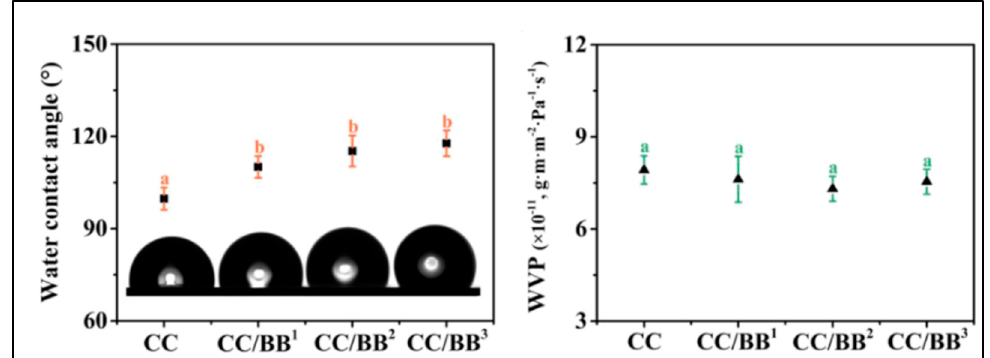
Figure 7. Water contact angle (WCA) values and the water vapour permeability (WVP) of sodium carboxymethylcellulose-carrageenan (CC) films alone and with self-assembled berberine-baicalin nanoparticles (CC/BB NPs) (taken from [80] with permission from the American Chemical Society).